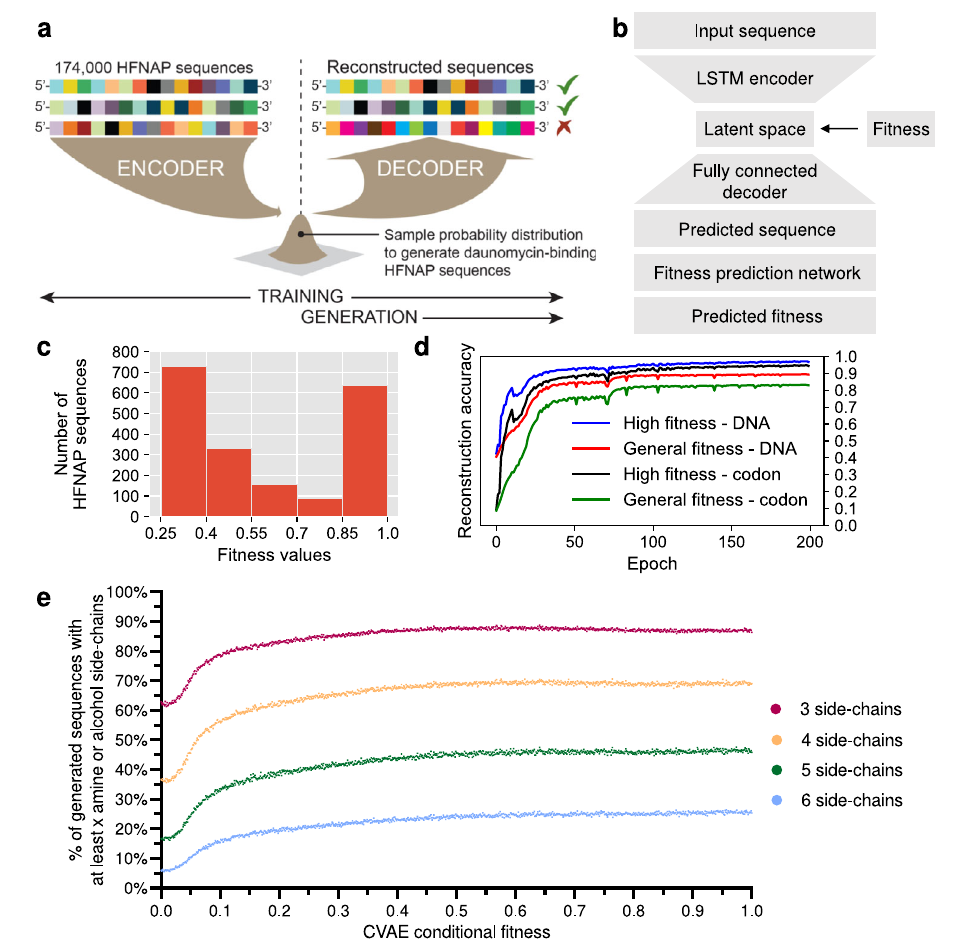
Fig. 4 | A machine learning model for generating HFNAPs with daunomy- cin binding af fi nity. a Overview of VAE structure, training and sequence gen- eration. Sequence inputsareencodedintoaprobability distribution.A sampleof the probability distribution is given to the decoder, which must reconstruct the originalinput sequence.Failureto accuratelyreconstruct thesequenceresults in penalties, which are used to optimize the parameters of the encoder, decoder, and probability distribution to improve reconstruction accuracy. After training, the probability distribution is then sampled from and given to the decoder to generate new HFNAP sequences. b The CVAE architecture used in this study. ConditionalVAEsintroduceanadditional,conditionalvariable,whichenablesthe user to specify a speci fi c condition or state. Here,we introduce sequence fi tness, a value between 0 and 1 that represents the anticipated binding af fi nity